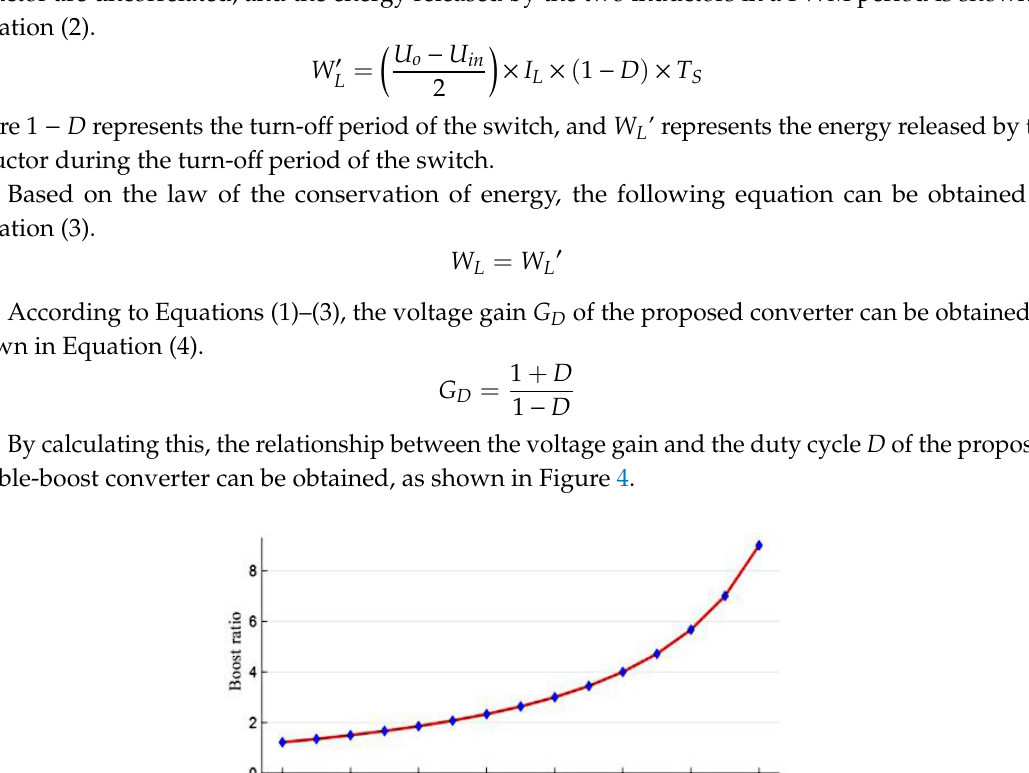
Figure 4. The relationship between voltage gain and duty cycle.